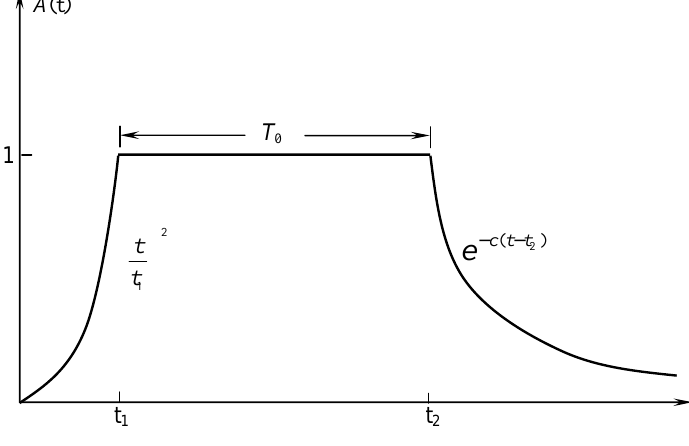
Fig. 2. Modulating function for non-stationary earthquake ground